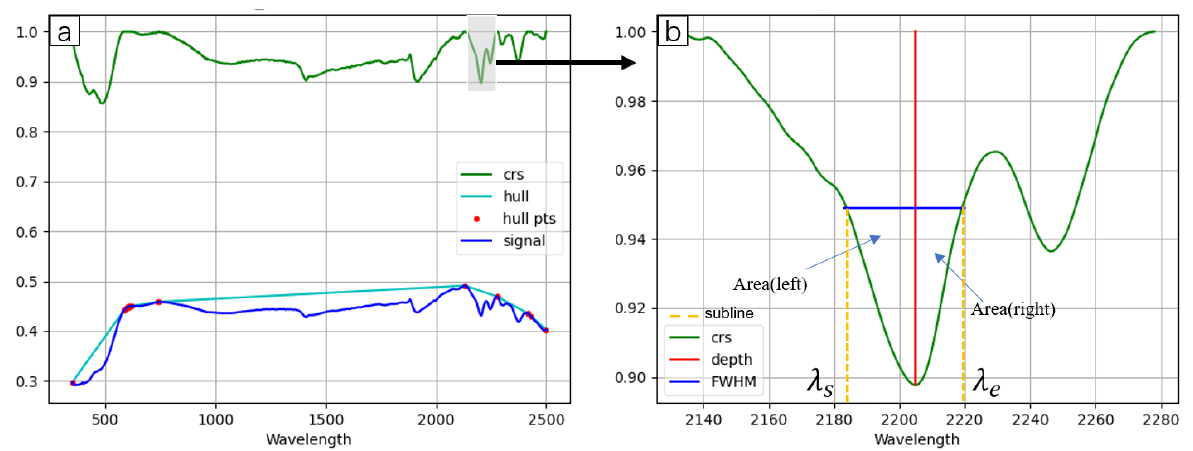
Figure 4. Spectrum characteristic parameter diagram: ( a ) continuum removal; ( b ) feature parameter extraction.